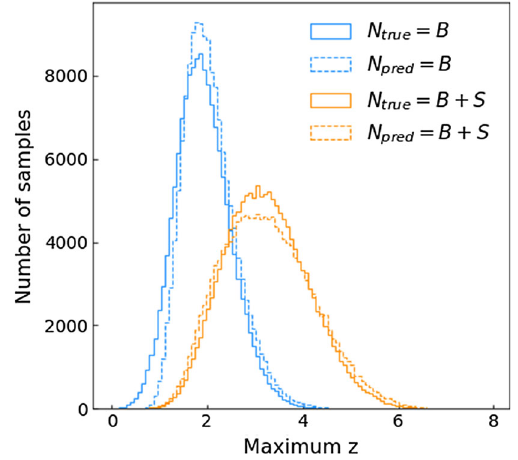
Fig. 3 The distribution of z max samples with no signal added (blue) and for samples with a 3 σ signifi- cance signal added (orange)